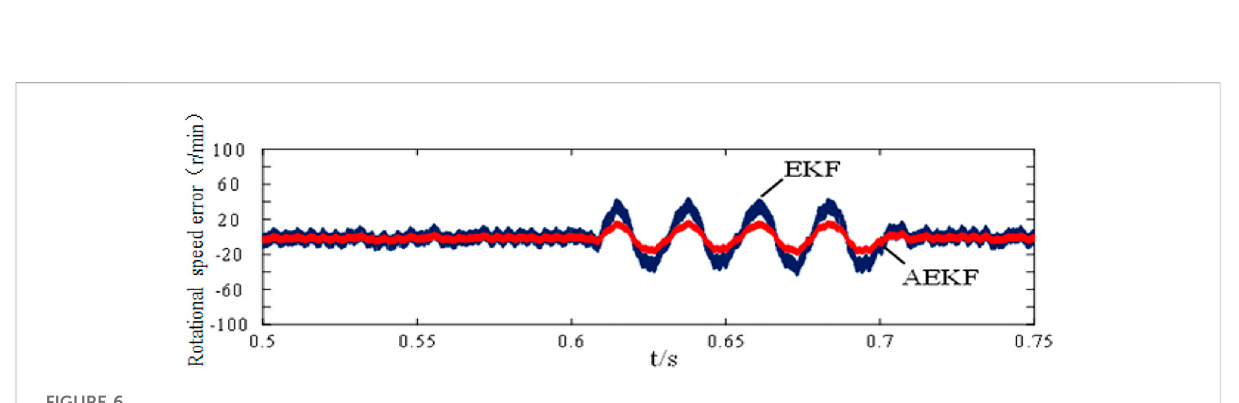
FIGURE 6 Speed error with internal disturbance.